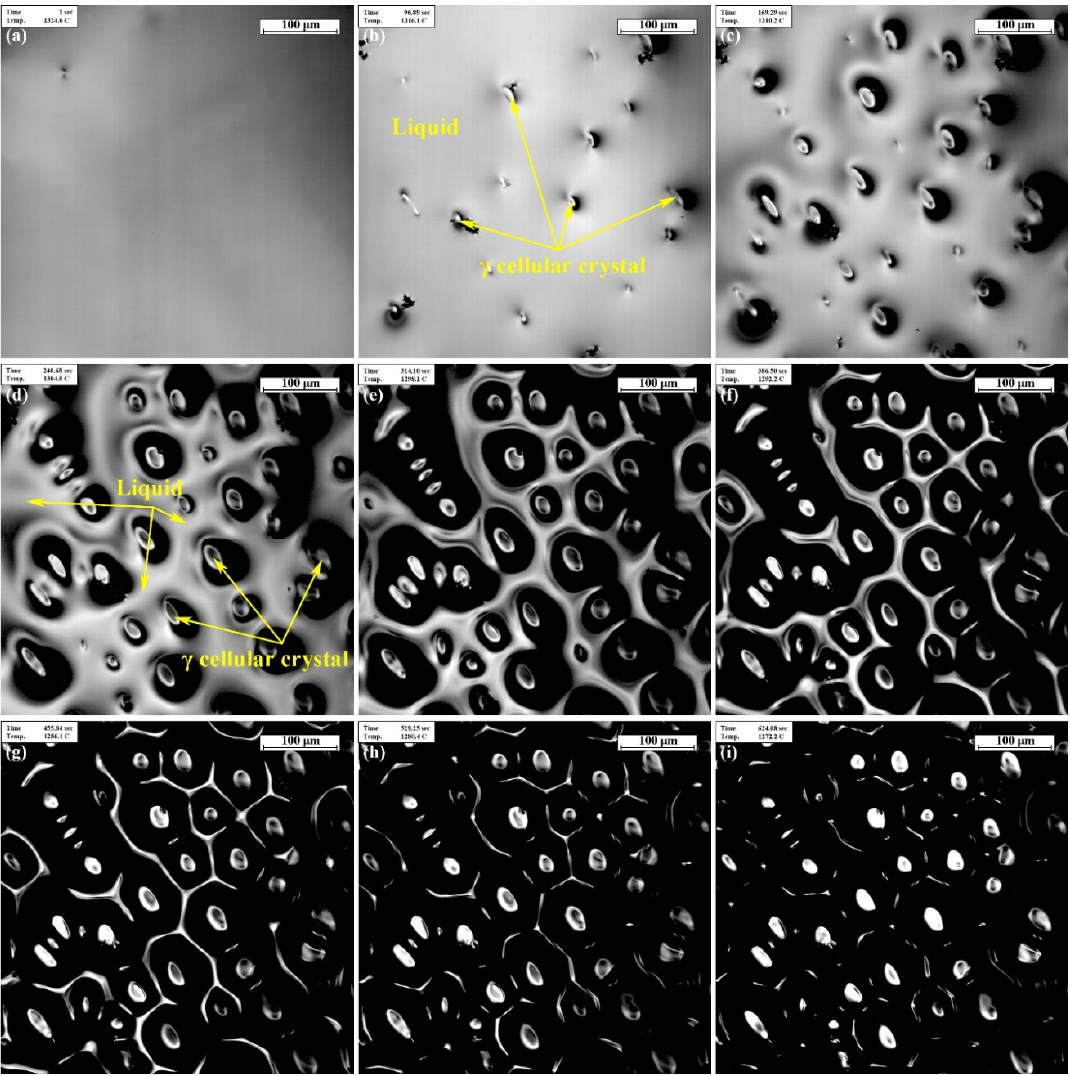
Figure 2. In situ observation results of the solidification process at different temperatures: ( a ) 1.00 s, 1324.6 °C; ( b ) 96.89 s, 1316.1 °C; ( c ) 169.29 s,1310.2 °C; ( d ) 240.68 s, 1304.0 °C; ( e ) 314.10 s, 1298.1 °C; ( f ) 386.50 s, 1292.2 °C; ( g ) 455.84 s, 1286.1 °C; ( h ) 529.25 s, 1280.4 °C; ( i ) 624.08 s, 1272.2 °C. The scale bars in the figures are 100 μm.